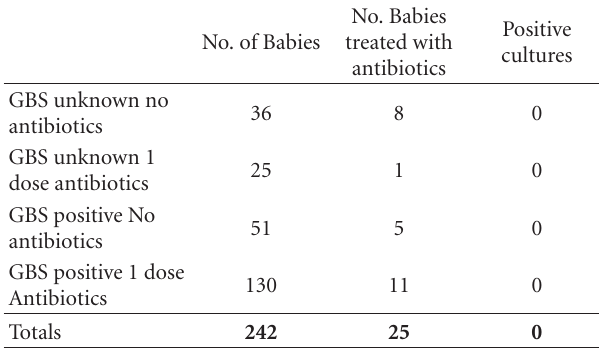
Table 1: Number of babies treated based on mother’s GBS status and doses of antibiotics given prior to delivery.